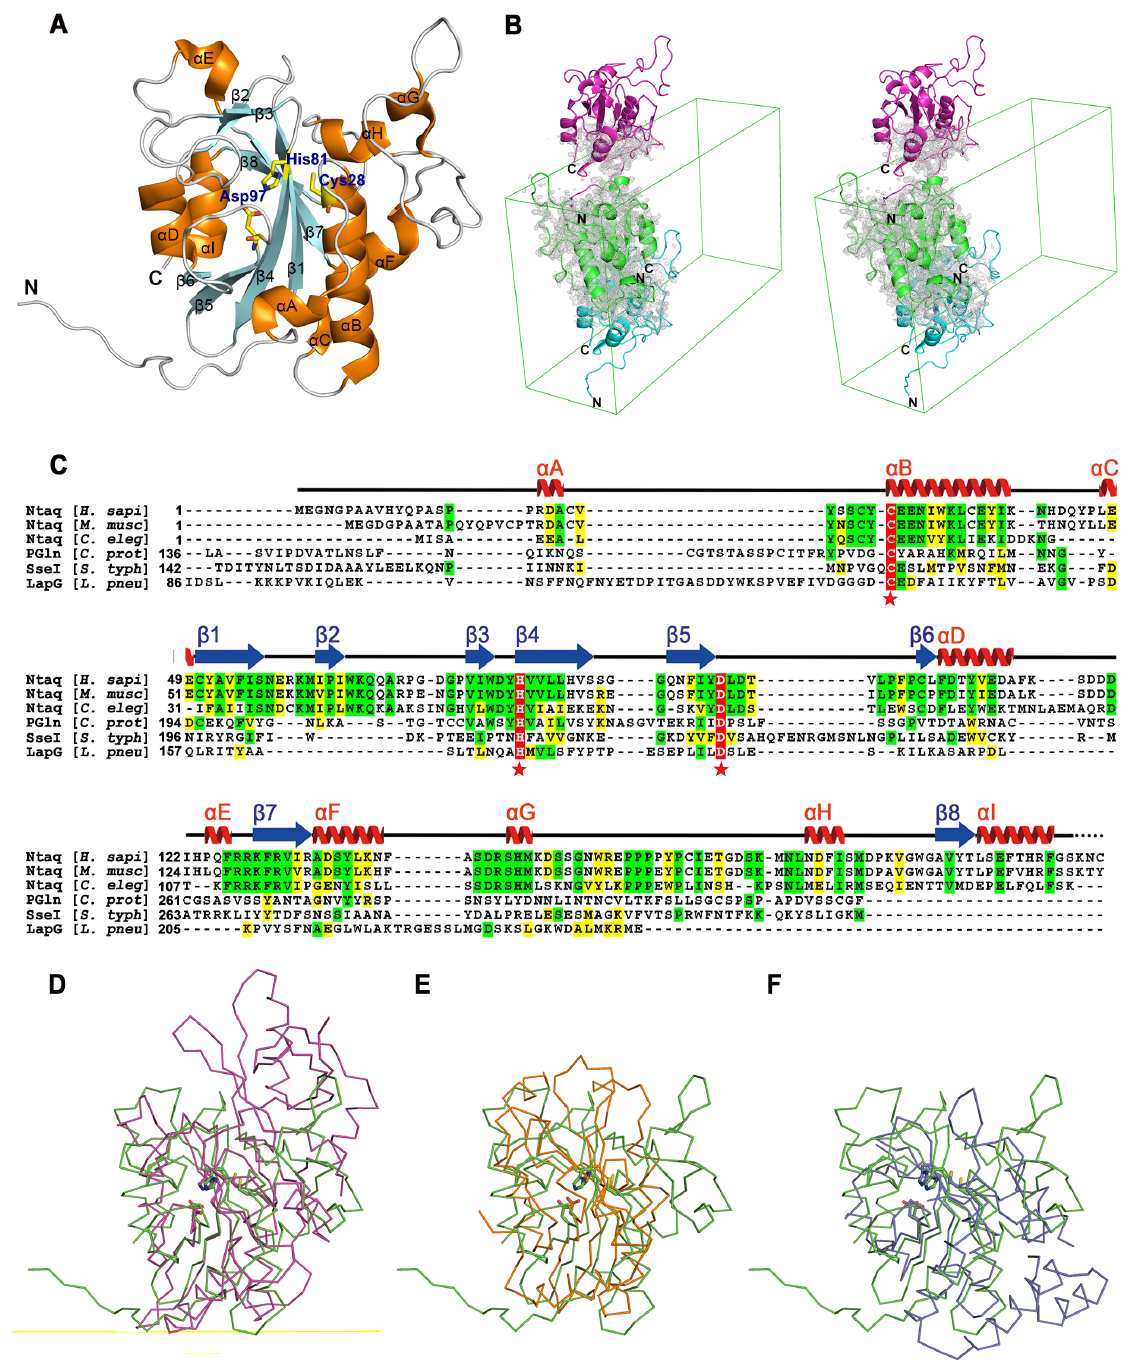
Figure 1. Overview of the crystal structure of hNtaq1. (A) Overall structure of hNtaq1. a -helices, b -strands, and loops are colored in orange, cyan, and white, respectively. The representative amino acid residues in the active site are shown as stick model (carbon, oxygen, nitrogen, and sulfur in yellow, red, blue, and gold color, respectively). (B) Stereo view of the crystallographic contact of hNtaq1 with a symmetry-related molecule. hNtaq1 and symmetry-related molecules are represented as green, cyan, and magenta cartoon, respectively. Unit cell is shown with green line and electron density map is shown as gray cloud. (C) Sequence alignment of hNtaq1 with Ntaq proteins from Mus musculus , Caenorhabditis elegans , protein- glutaminase from Chryseobacterium proteolyticum , secreted effector protein SseI from Sallonella typhimurium , and periplasmic protease LapG from Legionella pneumophila . Residues of the catalytic triad are represented by red asterisk below the amino acid sequences. Completely conserved, identical, moderately conserved residues are highlighted with red, green, and yellow shaded boxes, respectively. The secondary structure of hNtaq1 is shown on top of the sequence alignment. a -helix, b -sheet, and connecting region are represented by red spiral, blue arrow, and black line, respectively. Structural comparison of hNtaq1 with protein-glutaminase from C. proteolyticum (D), secreted effector protein SseI from S. typhimurium (E), and periplasmic protease LapG from L. peumophila (F). The catalytic triads are shown as stick models and main chains of hNtaq1, protein- glutaminase, SseI, and LapG are represented with ribbon diagram in green, magenta, orange, and blue, respectively.